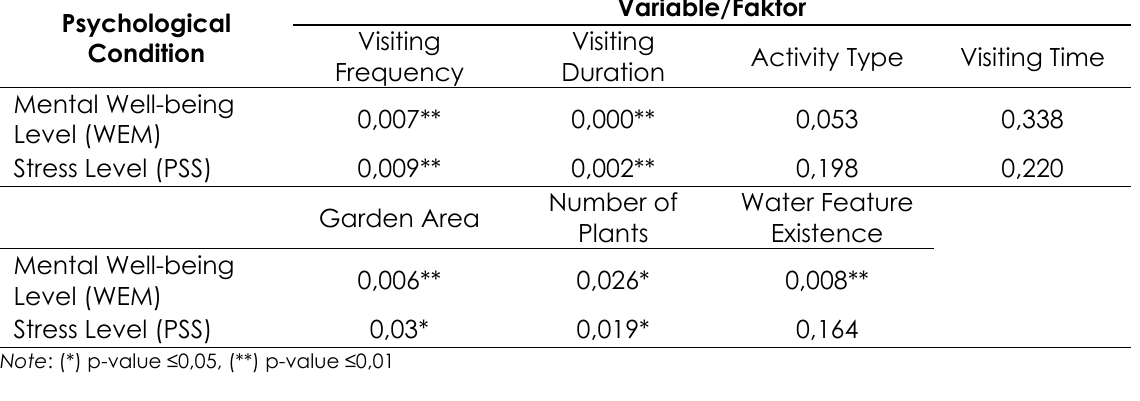
Table 5. The result of the p-value correlation test between psychological condition and some factors related to a home garden.